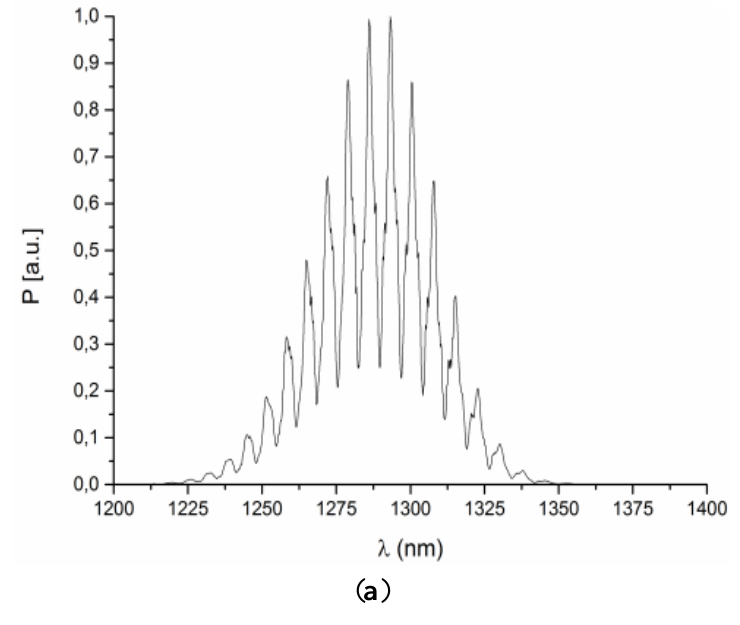
Figure 6. Measured signal from human blood with hematocrit: ( a ) HCT = 38.3%; ( b ) HCT =